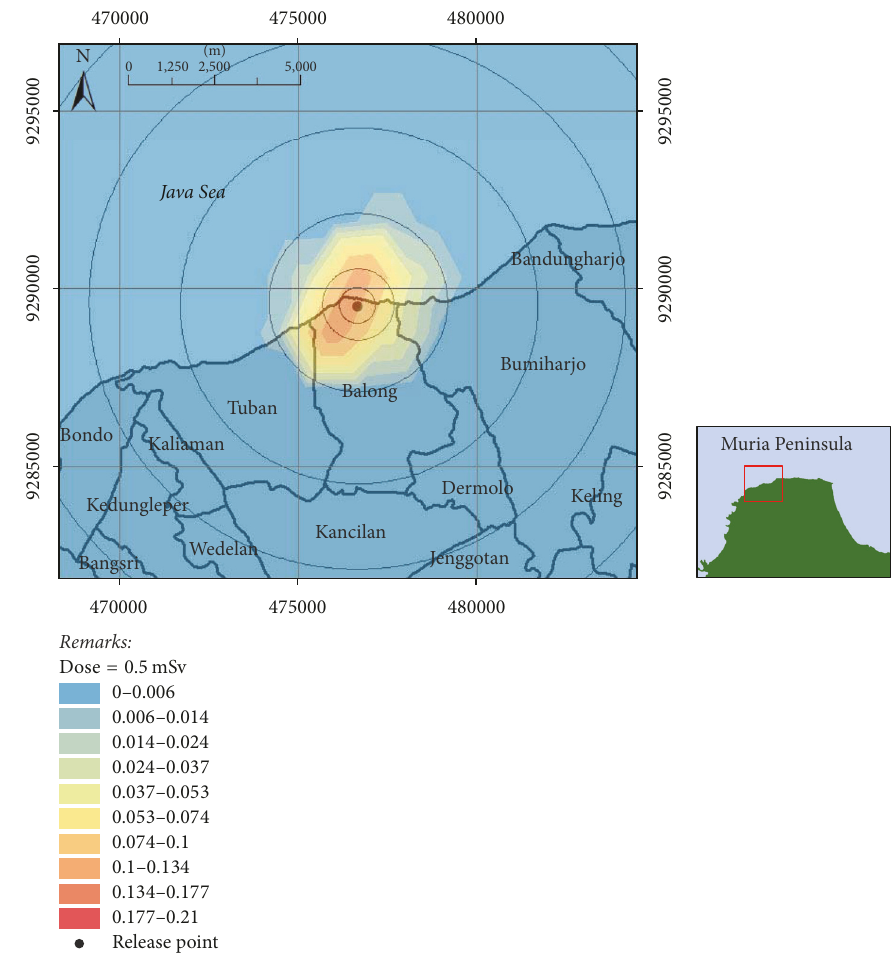
Figure 3: Dose distribution probability ( 𝐷 ≥ 0.5